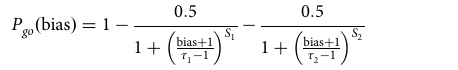
isolation table. The stimulator endpoint (a punctuate probe of 3 mm diameter mounted on the piezo stack) was placed in contact with the fi ngertip of their index fi nger, with their hand either in the palm down (four subjects) or palm up ( fi ve subjects) position. We did not control for the contact force as it was previously reported to play no role in behavioral performance 8 . The participants wore noise canceling headphones (3 M Peltor WorkTunes Pro HRXS220A) and masking white noise was played throughout the session. The task was guided with visual cues displayed on a 60 inch monitor viewed at a 140 cm distance. Each trial started with a 0.5s pre-stimulus interval during which a red fi xation dot was displayed, followed by a 2.5 s stimulus interval cued with the fi xation dot turning green. During this interval, two successive vibrations (0.5 s duration each) were delivered to the fi n- gertip, preceded, separated and followed by a 0.5s silent period. A